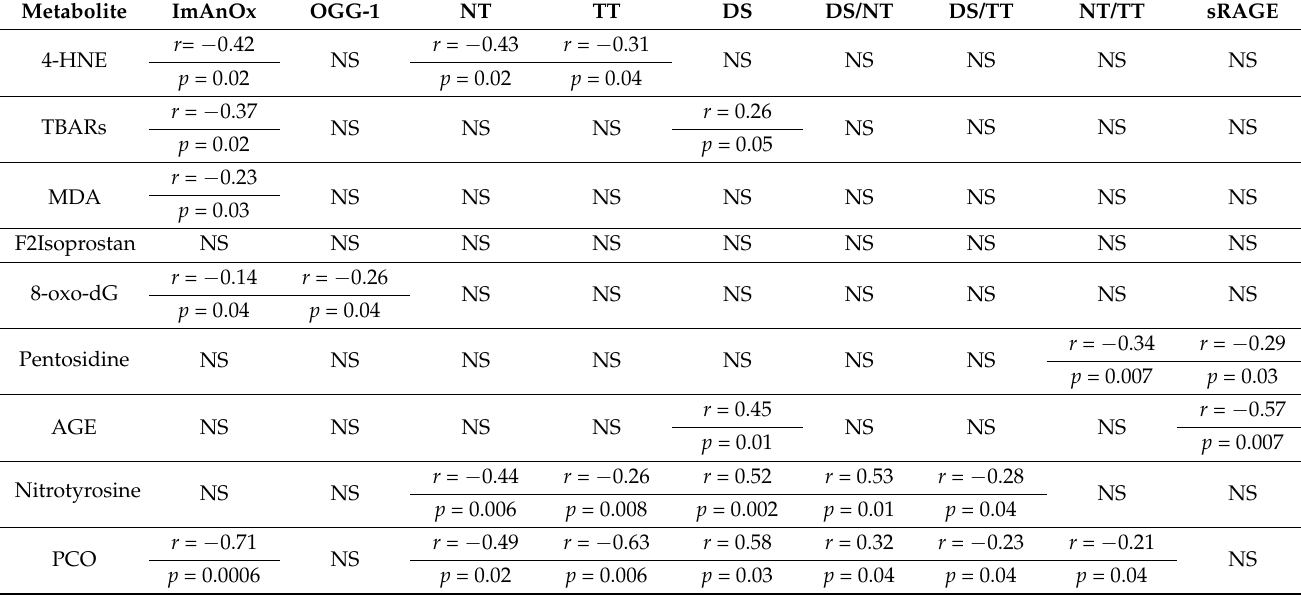
Table 7. Correlation analysis between studied parameters in SLE patients.